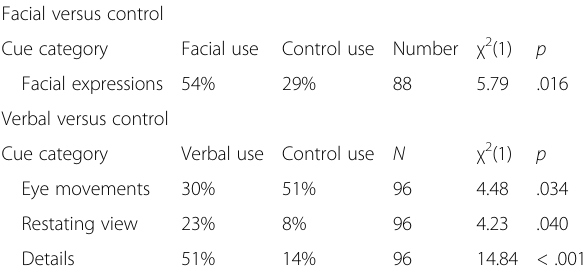
Table 3 Significant differences between training conditions and control in percentage of participants reporting cue usage